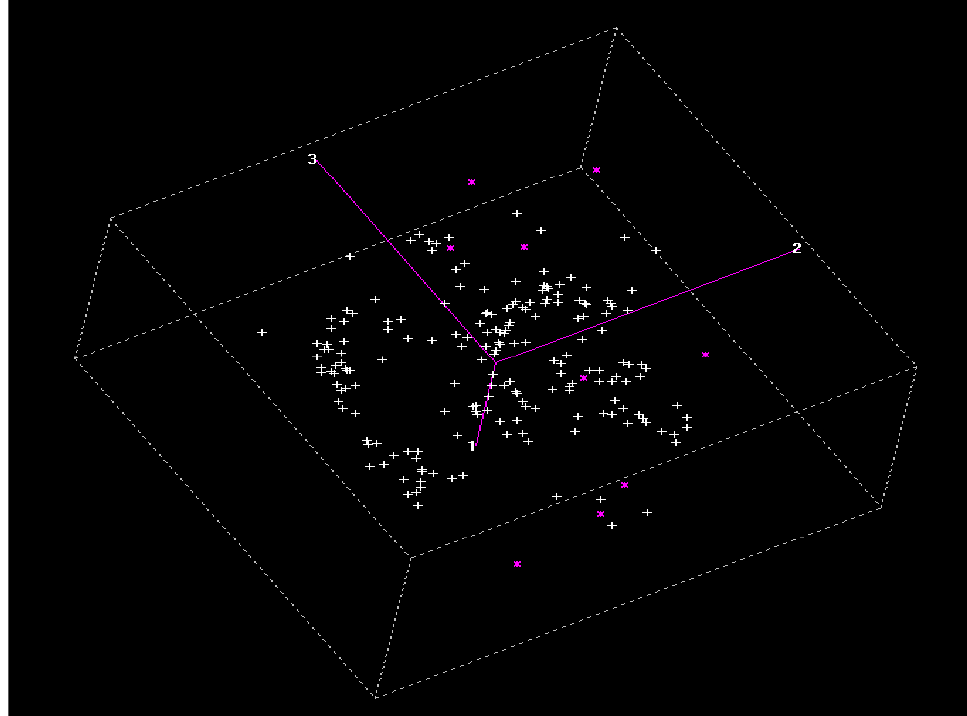
Figure 1. 3D view showing outlier samples.